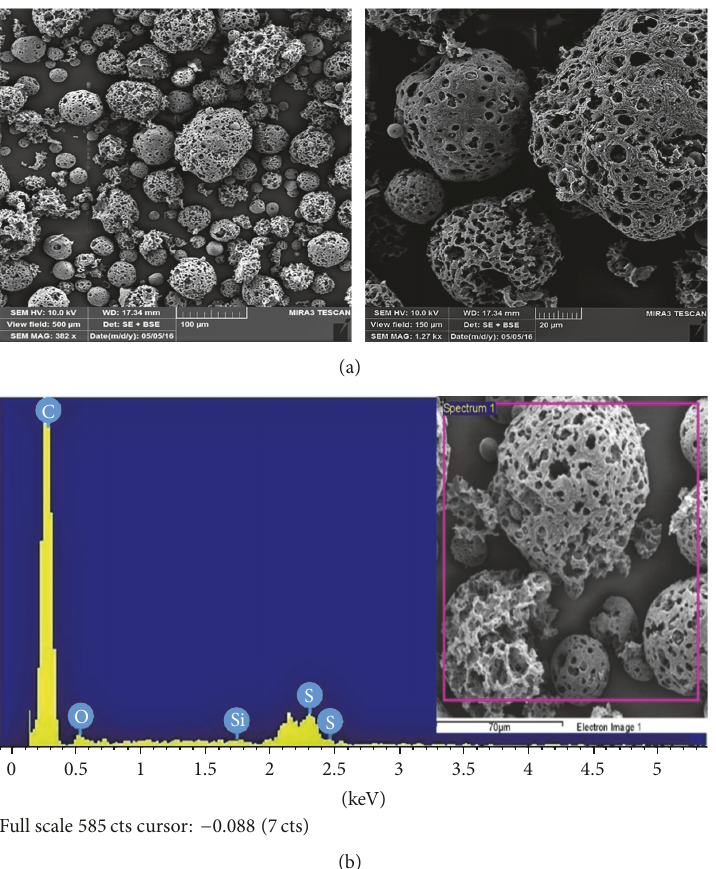
Figure 4: Acid-treated FA (a) SEM micrographs (view field: 500 and 150 𝜇 m; voltage: 10kV; resolution: 382x and 1.27 kx); (b) EDX spectrum.